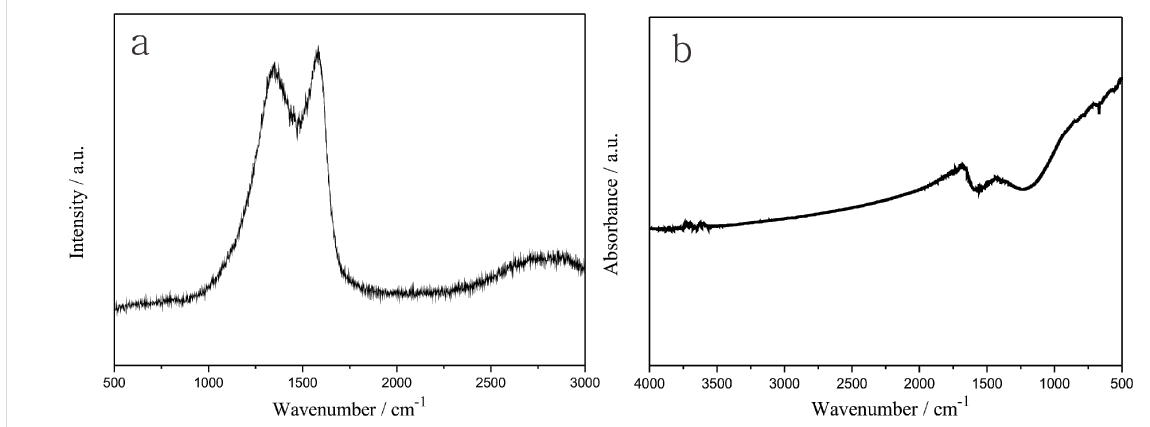
Figure 2: Raman spectrum (a) and FTIR spectrum (b) of the ECNFs.